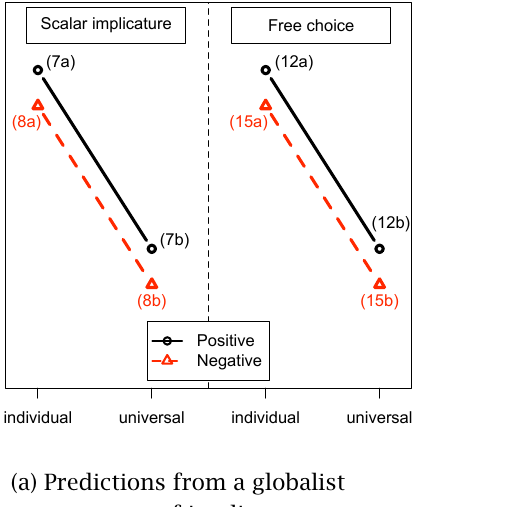
(b) Predictions from a localist treatment of implicatures